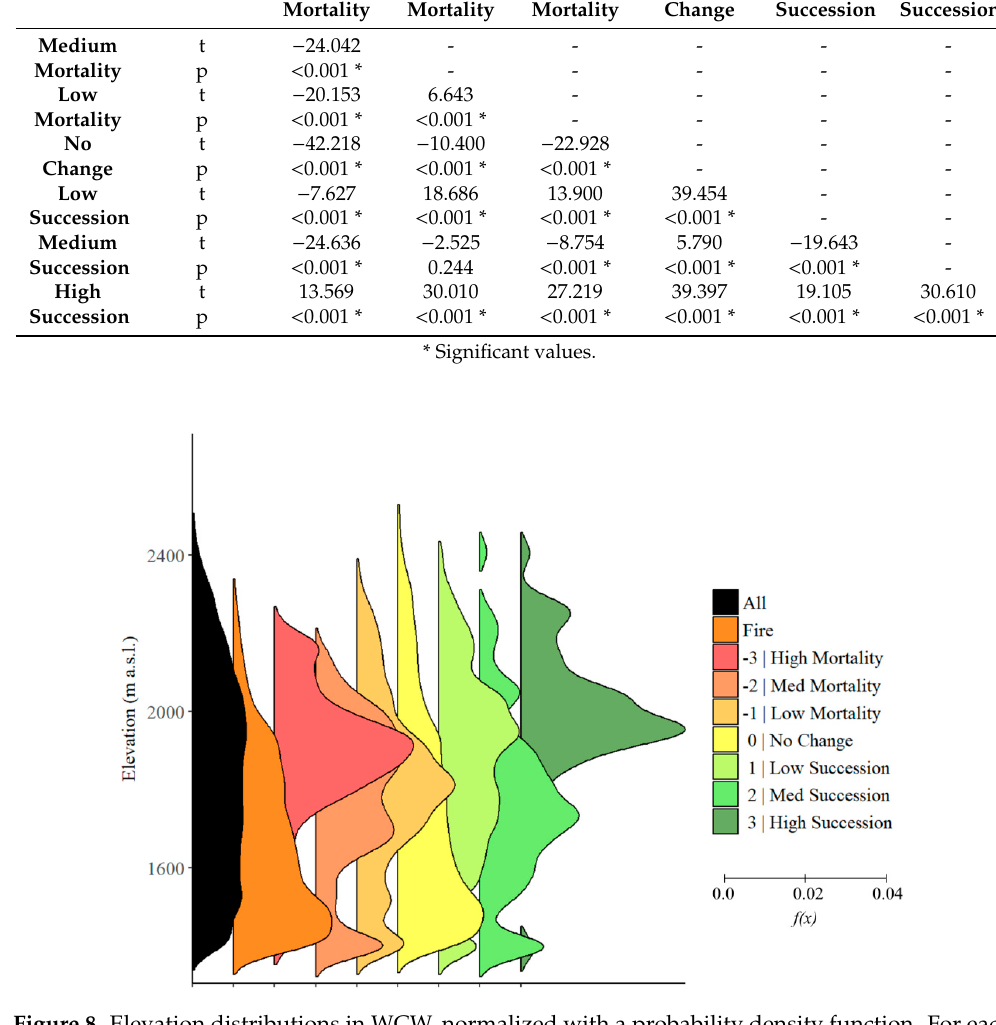
Figure 8. Elevation distributions in WCW, normalized with a probability density function. For each category, the hypsometric distribution of elevation within that category is displayed. The further right a curve extends from each baseline, the more likely it is to find values at that elevation within each category. Across all WCW, in black, elevation is evenly distributed, with elevation above 2200 m a.s.l. being less common. Fire, in orange, was more likely below 1600 m a.s.l., and high mortality and high succession were more likely at ATE elevations, between 1800–2100 m a.s.l. Corresponding t-tests can be seen in Table 3. Table 3. Results of elevation t-test between change classes. Significant values in bold. Significant differences were seen in 20 out of 21 tests.